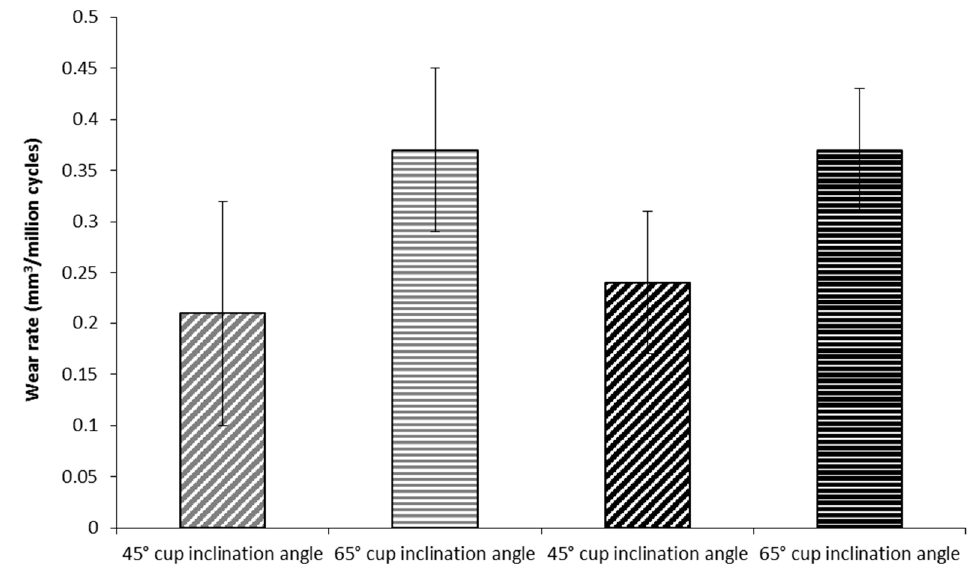
Figure 6. Severity of edge loading (mean ± 95% confidence limits, n = 3) of 36 mm diameter BIOLOX ® delta ceramic-on-ceramic bearings under two axes and three axes of rotation conditions with 45° and 65° cup inclination angles and 1, 2, 3 and 4 mm of medial-lateral translational mismatch conditions (offset deficiency).